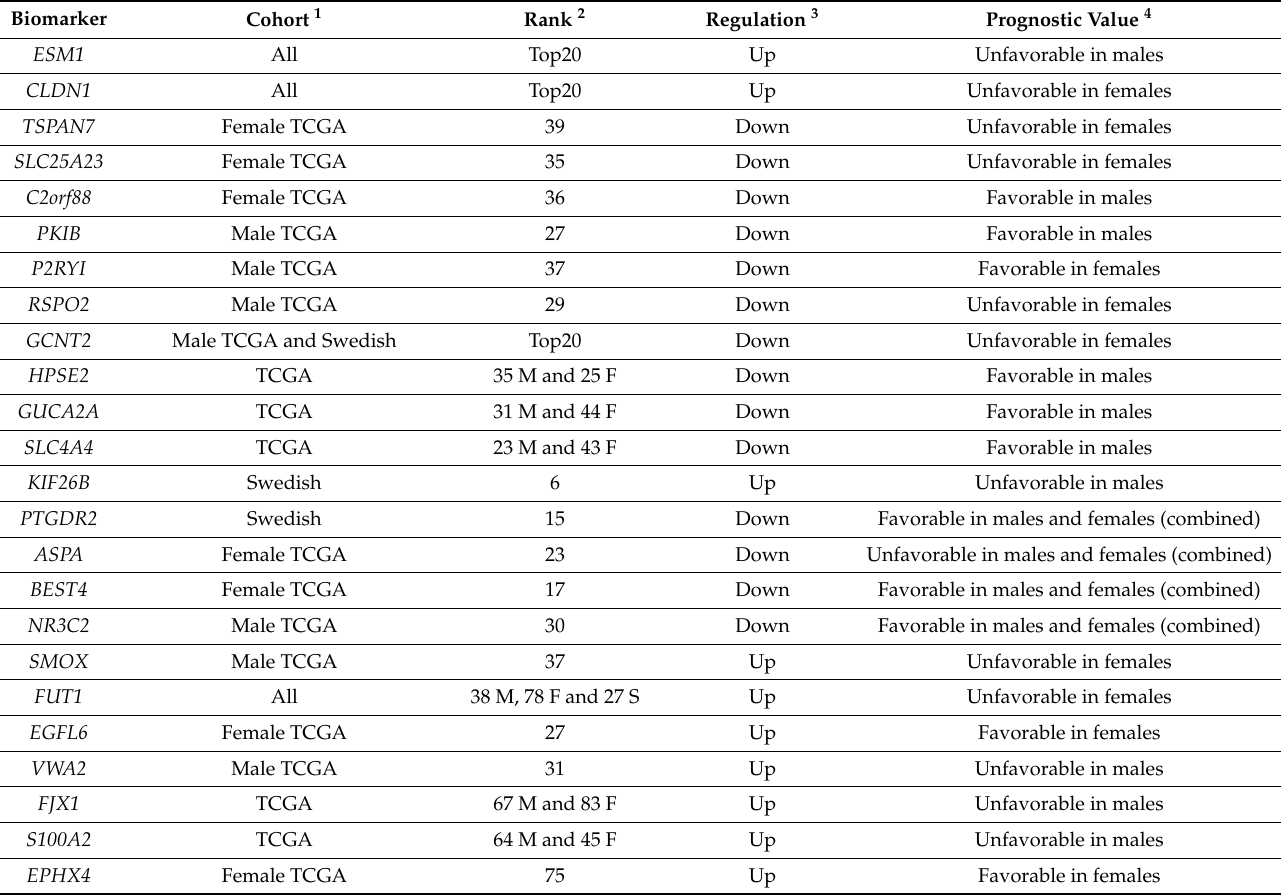
Table 2. Prognostic biomarkers identified in the TCGA and our Swedish